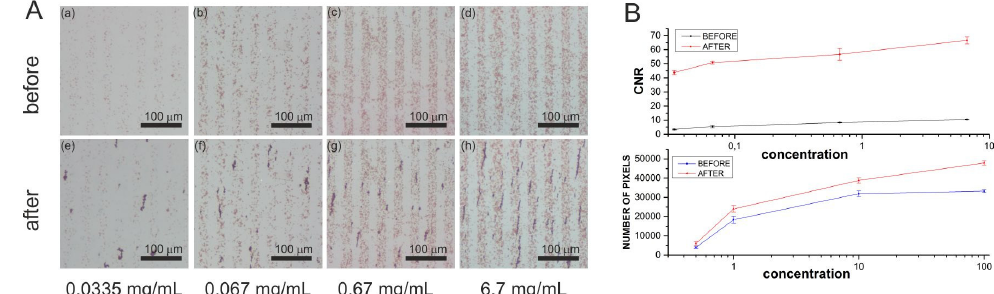
Figure 4. ( A ) Optical micrographs of some of the gold surface before and after magnetic signal amplification; ( B ) The contrast-to-noise ratio ( CNR ) and calculated number of pixels of the images in ( A ) for the corresponding concentrations in the range of 0.0335–6.7 mg/mL. Values are mean ± standard error of the mean.